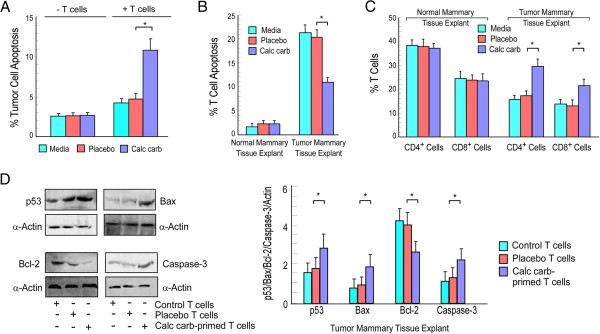
Calcarea carbonica induces T cell-mediated apoptosis of primary mammary tumor. (A) T cells isolated from patient’s peripheral circulation were primed with media-/placebo-/calcarea carbonica-treated tumor supernatant for 72 h and then co-cultured with primary mammary tumor for 48 h. In parallel, primary mammary tumor cells was directly exposed to placebo-/calcarea carbonica for 48 h in the absence of T cells. Tumor cell apoptosis was then scored by Annexin-V-PE/7-AAD-positivity and represented graphically. (B) T cells isolated from normal and cancer patient’s peripheral blood were co-cultured with control mammary tissue and tumor mammary tissue explants, respectively for 48 h and percent T cell apoptosis was scored by Annexin-V-PE/7-AAD-positivity. (C) The same experimental set was analysed for percentage of CD4+ and CD8+ T cells flow cytometrically. (D) Lysates of primary breast cancer cells co-cultured with or without placebo-/calcarea carbonica-primed T cells of same patient’s blood were Western blotted for the analysis of p53, Bax, Bcl-2 and active-caspase-3. α-Actin was used as loading control. *p < 0.05 and **p < 0.001 when compared with respective control/mammary tissue explant sets and placebo/drug-treated sets.